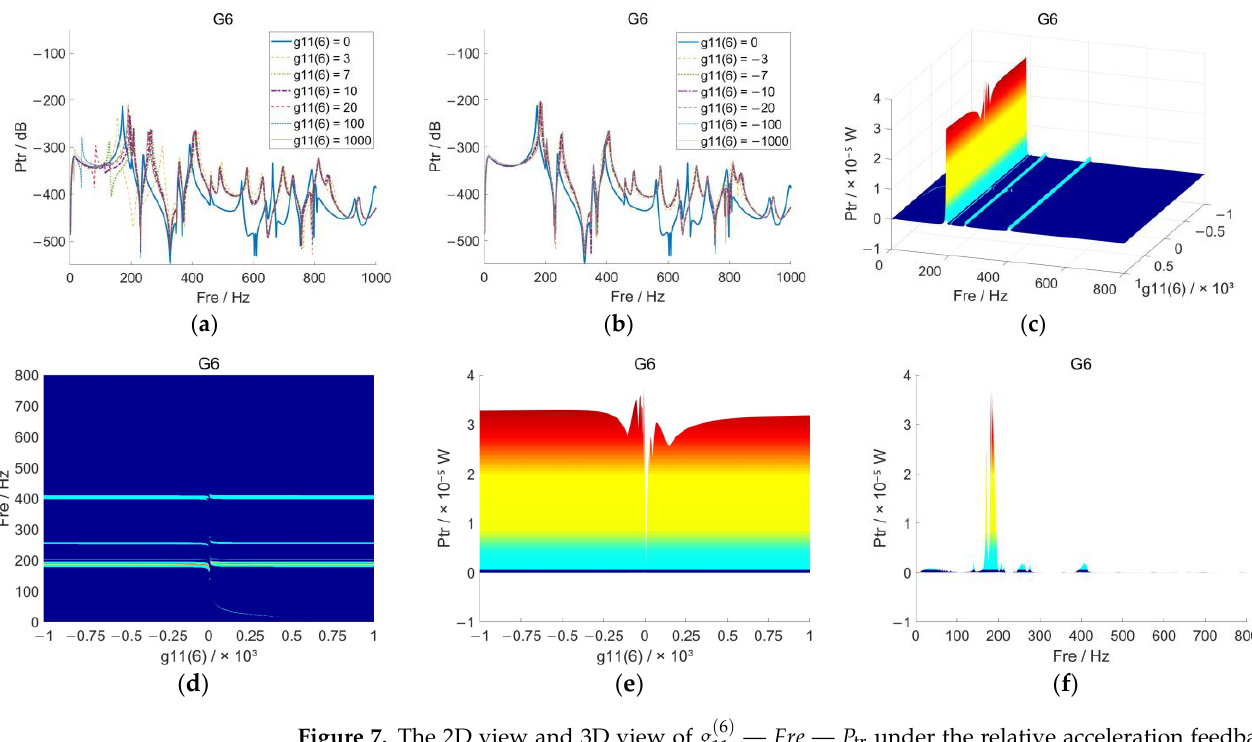
( 6 ) P under the relative acceleration feedback con- g — Fre — Figure 7. The 2D view and 3D view of ( ) 6 Figure 7. The 2D view and 3D view of g — Fre — P tr under the relative acceleration feedback 11 tr 11 ( 6 ) ∈ (cid:0) − 10 3 , 10 3 (cid:1) , the step size is set to 1): ( a ) comparison of P tr curves under control method ( g P curves under ( ) 6 0 g  ; 10 10 g ,  − , the step size is set to 1): ( a ) comparison of trol method ( ( ) ( ) 6 3 3 11 11 tr 11 ( 6 ) > 0; ( b ) comparison of P tr curves under g ( 6 ) < 0; ( c ) the 3D view of P tr curve under continuous g P curves under ( ) 6 P curve under continuous variation 11 11 0 g  ; ( c ) the 3D view of ( b ) comparison of 11 tr tr ( 6 ) variation of g ; ( d ) X-Y plane view; ( e ) X-Z plane view; ( f ) Y-Z plane 11 g ; ( d ) X-Y plane view; ( e ) X-Z plane view; ( f ) Y-Z plane view. of ( ) 6